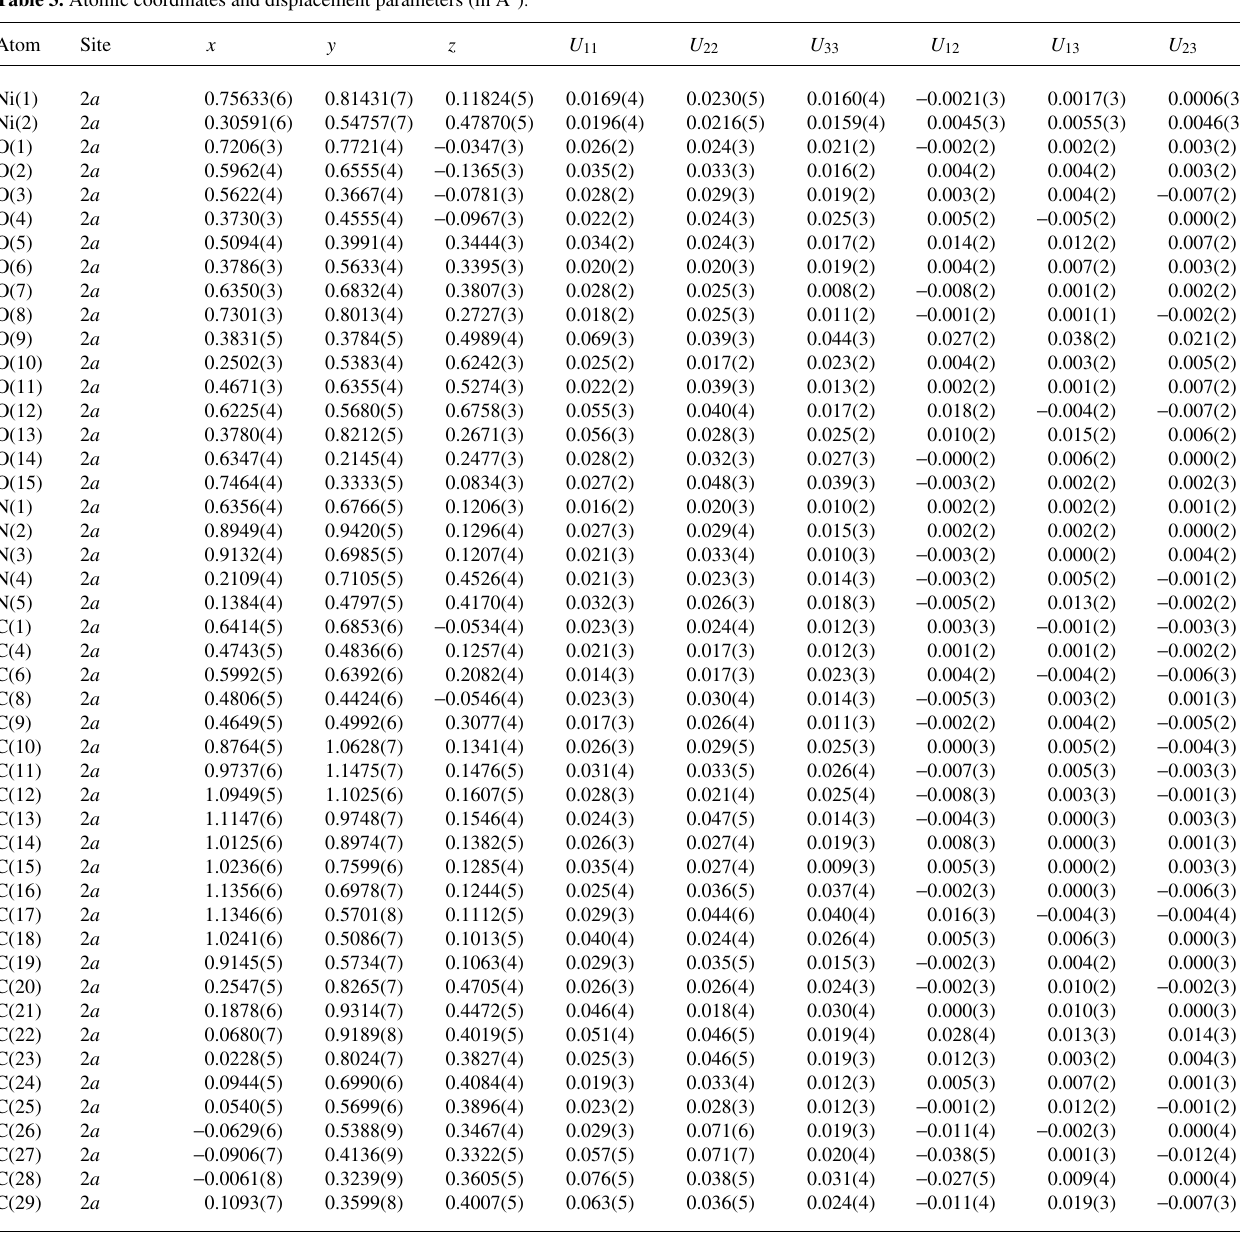
Table 3. Atomic coordinates and displacement parameters (in Å 2 )